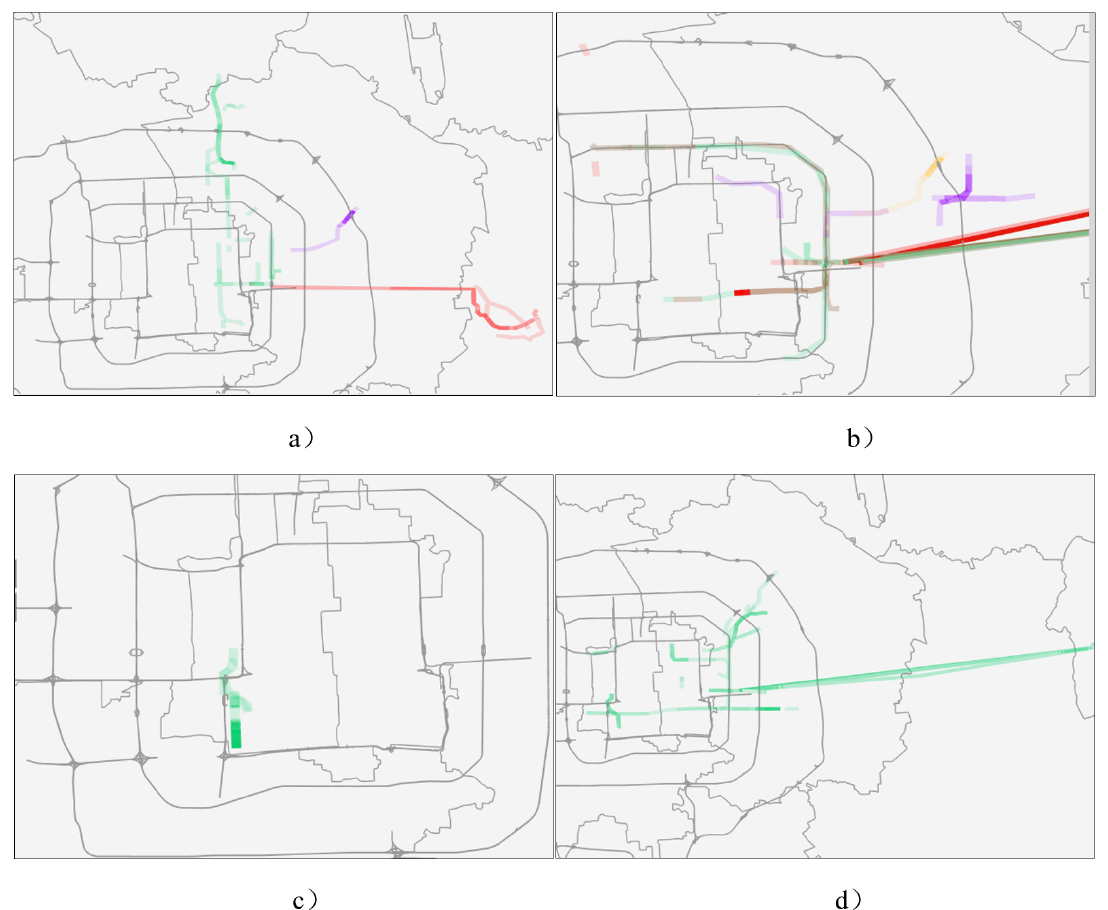
Figure 11. Passenger 2D travel trajectory view ( a ) 2D travel trajectory with different travel, ( b ) 2D travel trajectory similar to travel, ( c ) 2D travel trajectory of normal card travel, ( d ) 2D travel trajectory of abnormal card